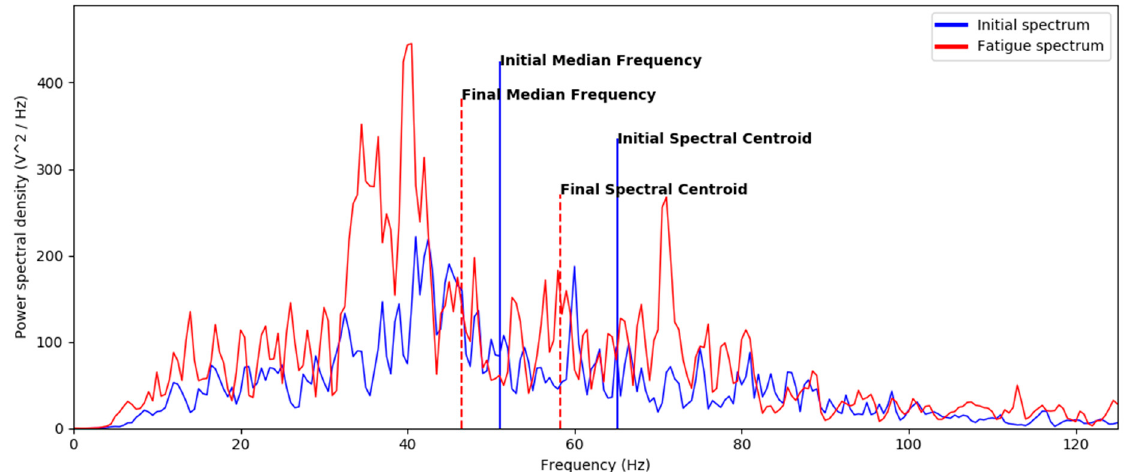
Figure 3. EMG power spectrum obtained for the initial time window (at the beginning of the 30-STS) and the final time window (the end of the 30-STS). As it is shown, a decrease in both the MDF and the SC occurs during the exercise.